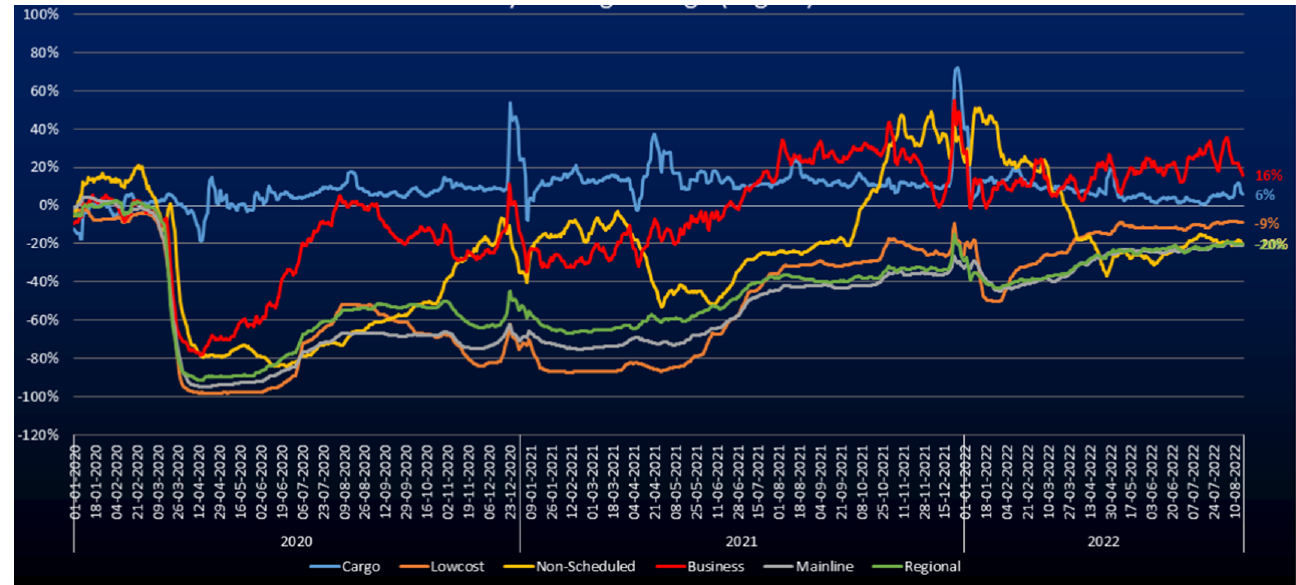
Figure 3. EUROCONTROL Market performance in percentage and COVID-19 recovery Source: EUROCONTROL (2022:6).